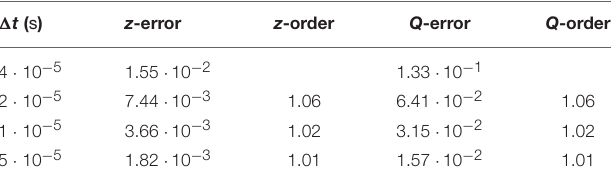
TABLE 2 | Relative errors in bubble position z and flow rate Q at t = 0 . 00144s and estimated convergence orders for the links-in-series test case computed with the forward Euler method.